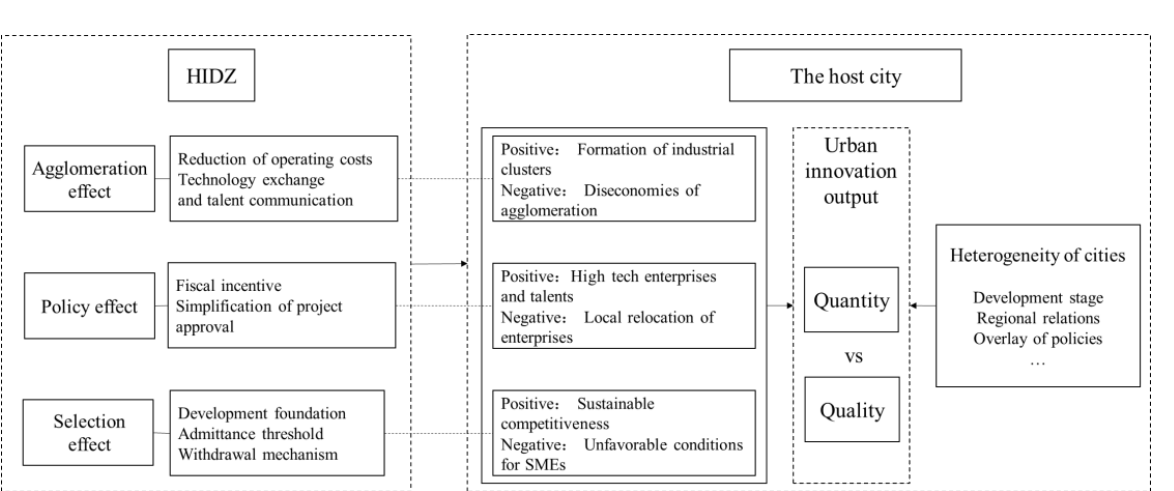
Figure 1. Influence path of HIDZs on Urban Innovation Development.